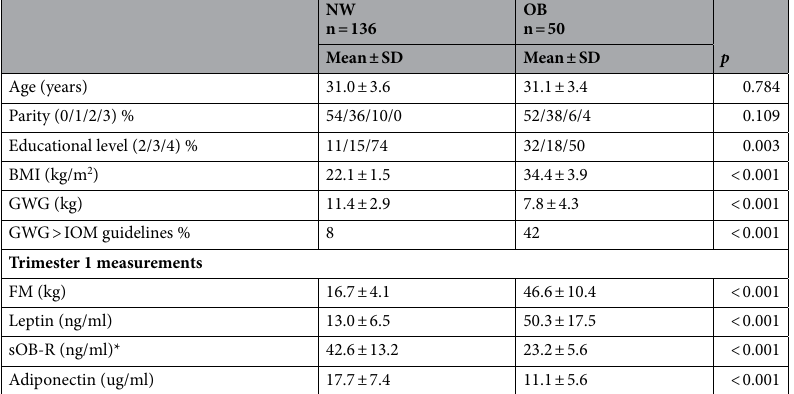
Table 1. Maternal characteristics. p denotes significance between NW and OB using t-test for continuous variables, Chi square test for parity and education, and Fisher’s exact test for GWG > IOM guidelines. Educational levels: 2 = graduated from 3 year Swedish gymnasium (equivalent to upper secondary school), 3 = less than 3 years of university, 4 = more than 3 years of university. *sOB-R analysis was made on a subset of women; n = 84 for NW. GWG, gestational weight gain (from trimester 1 to 3), IOM, Institute of Medicine; NW, women of normal weight; OB, women with